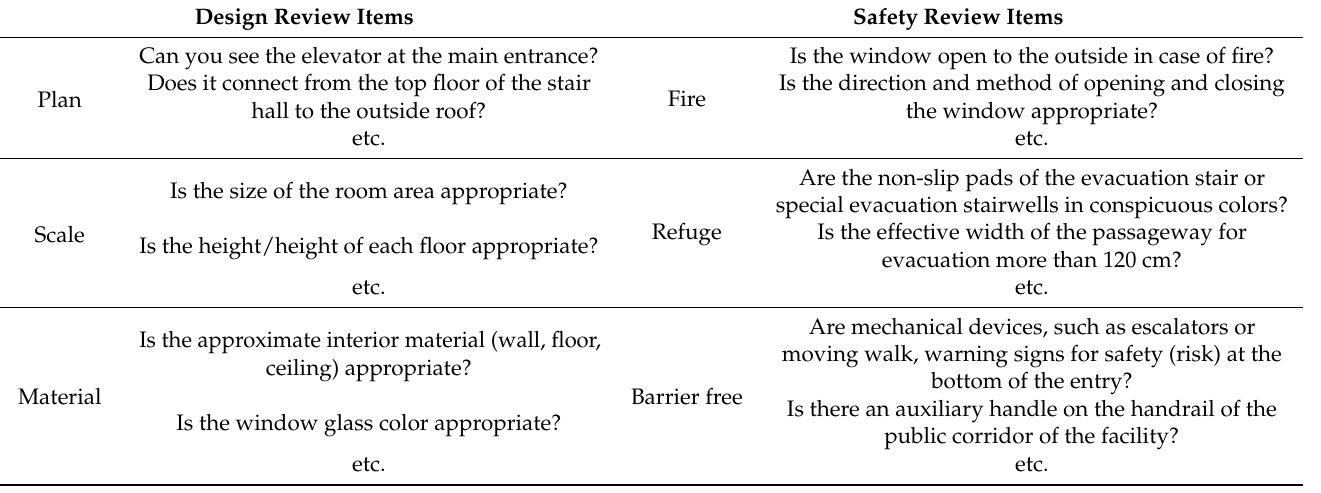
Table 1. Example items for a design